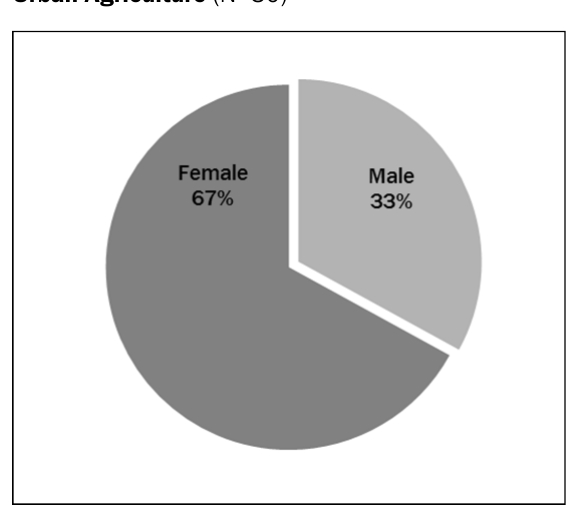
Figure 3. Employment Status of Urban